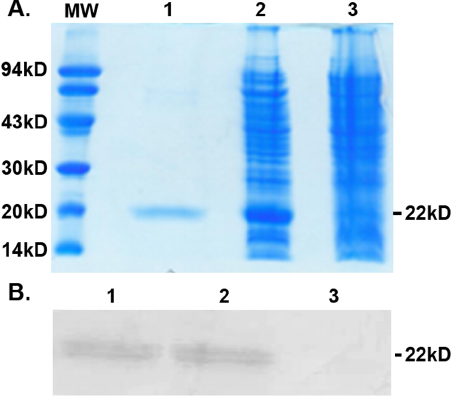
Figure 1. SDS-PAGE and immunoblotting of expression and purified rhEndostatin. A. SDS-PAGE of rhEndostatin. Lane 1: Pre- stained molecular weight markers; Lane 2: Purified rhEndostatin; Lane 3: Induced bacterial lysates; Lane 4: Non-induced bacterial lysates. (B). Immunoblotting of rhEndostatin. Lane 1: Purified rhEndostatin Lane 2: Whole bacterial cell lysates after IPTG induction; Lane 3: Non-induced bacterial lysates.